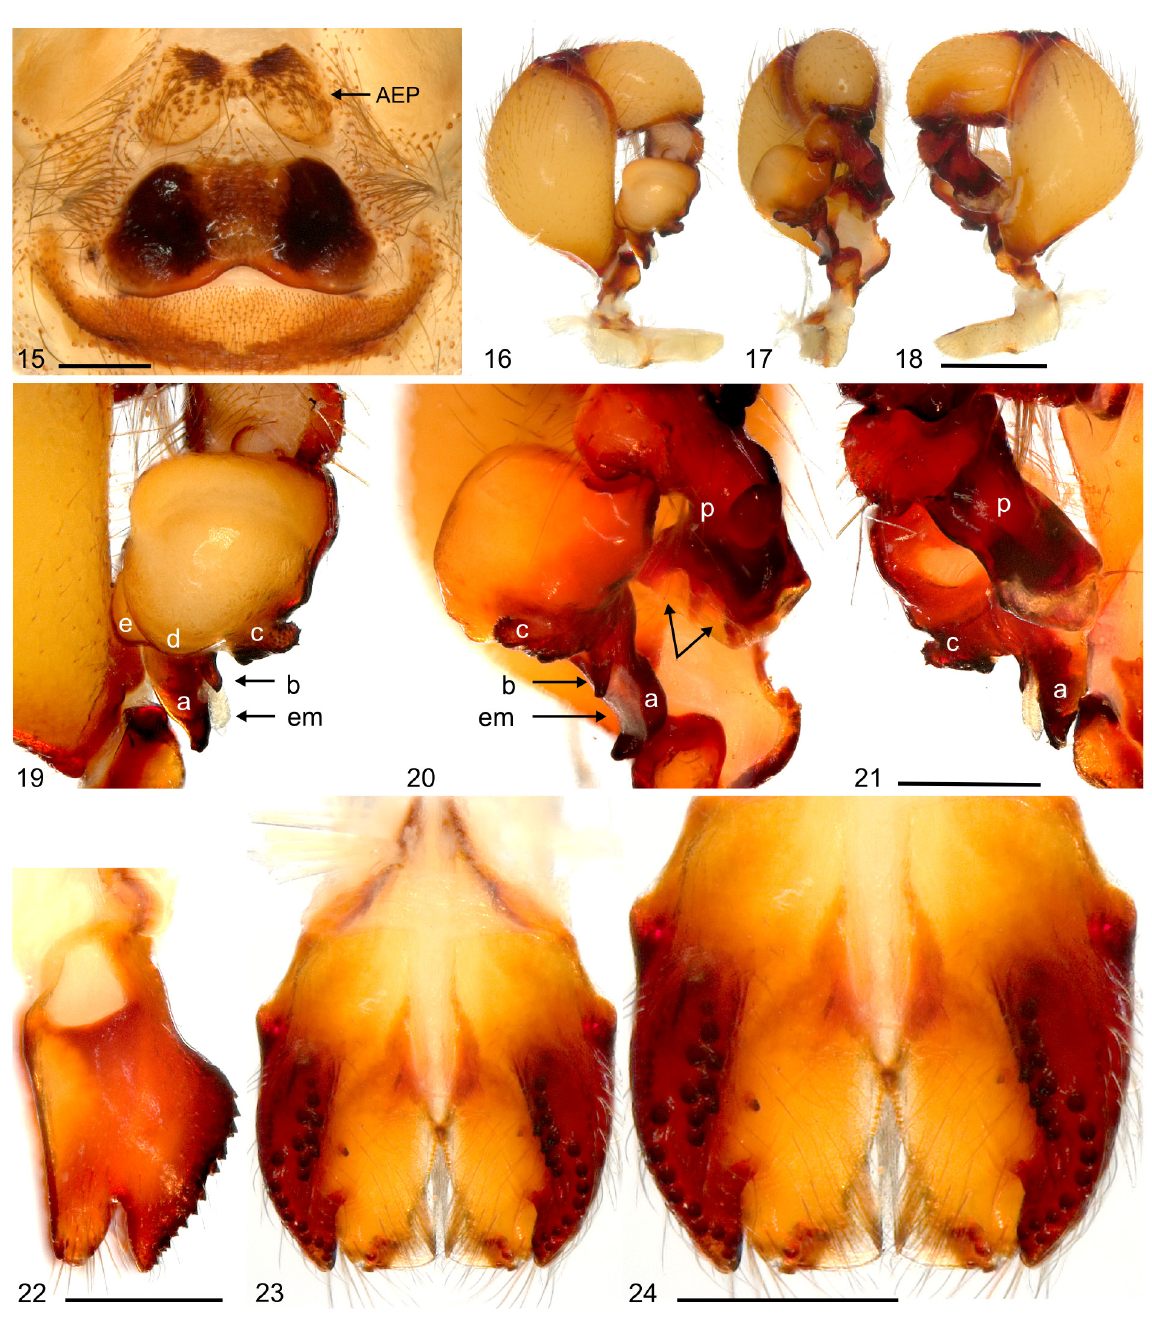
Figs 15–24. Artema atlanta . 15 . Epigynum (MRAC 215041, Benin). 16–18 . Male left pedipalp (MRAC 120766, Sudan), prolateral, dorsal, and retrolateral views. 19–21 . Male left bulb and procursus, prolateral, dorsal, and retrolateral views, arrows in Fig. 20 show notches on distal margin of procursus. 22–24 . Male chelicerae (same specimen), lateral and frontal views. Scale lines: 15, 19–24 = 0.5 mm; 16–18 = 1